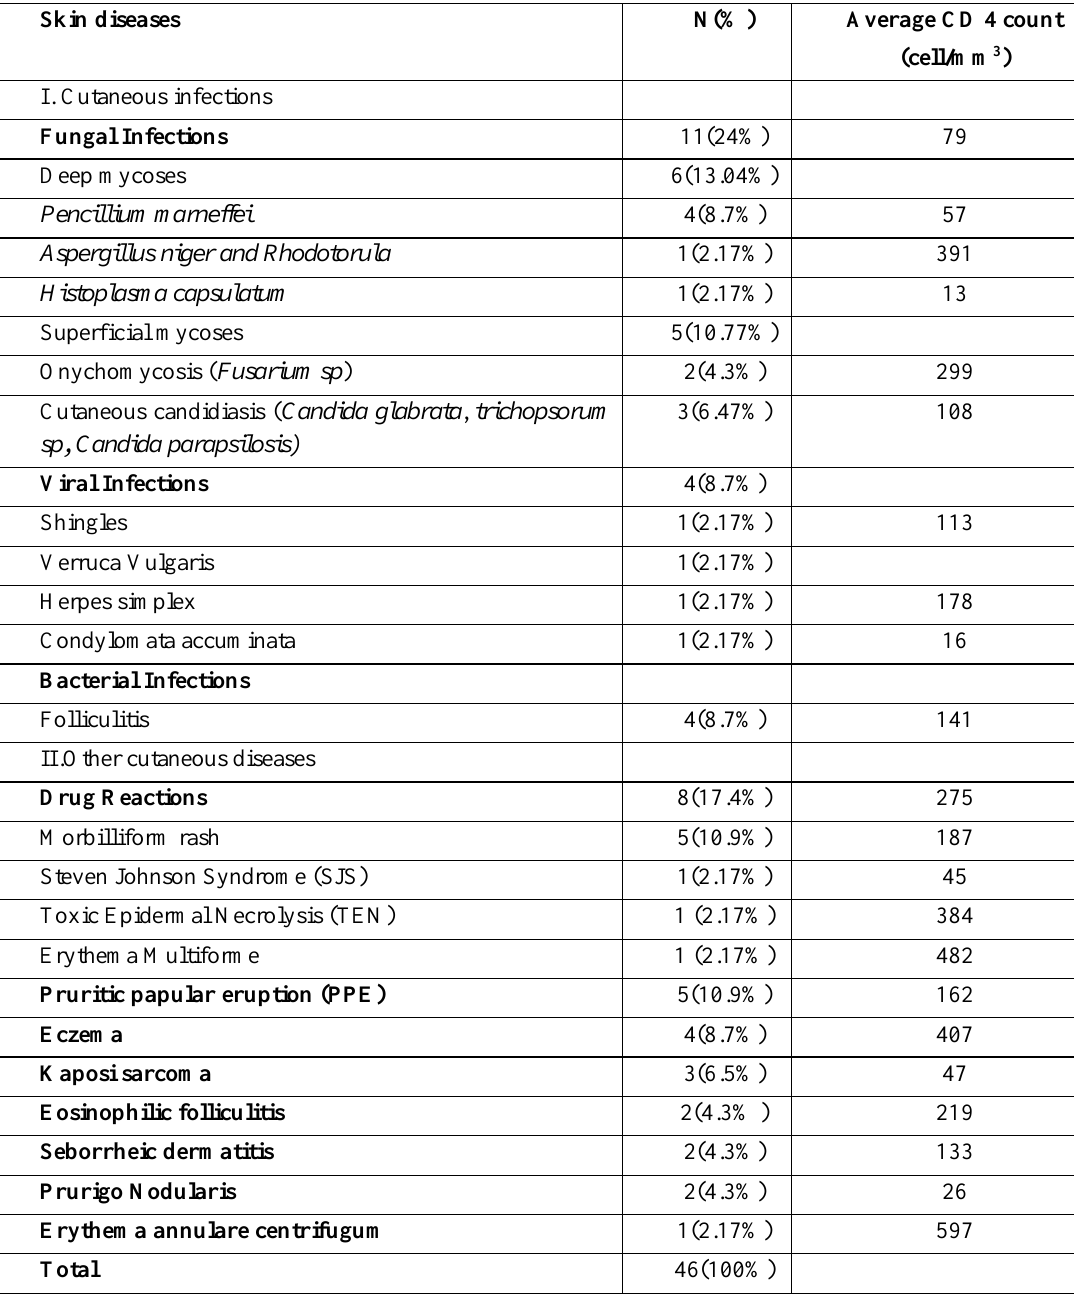
Table 1. Spectrum of cutaneous infections, other cutaneous diseases and CD4 count